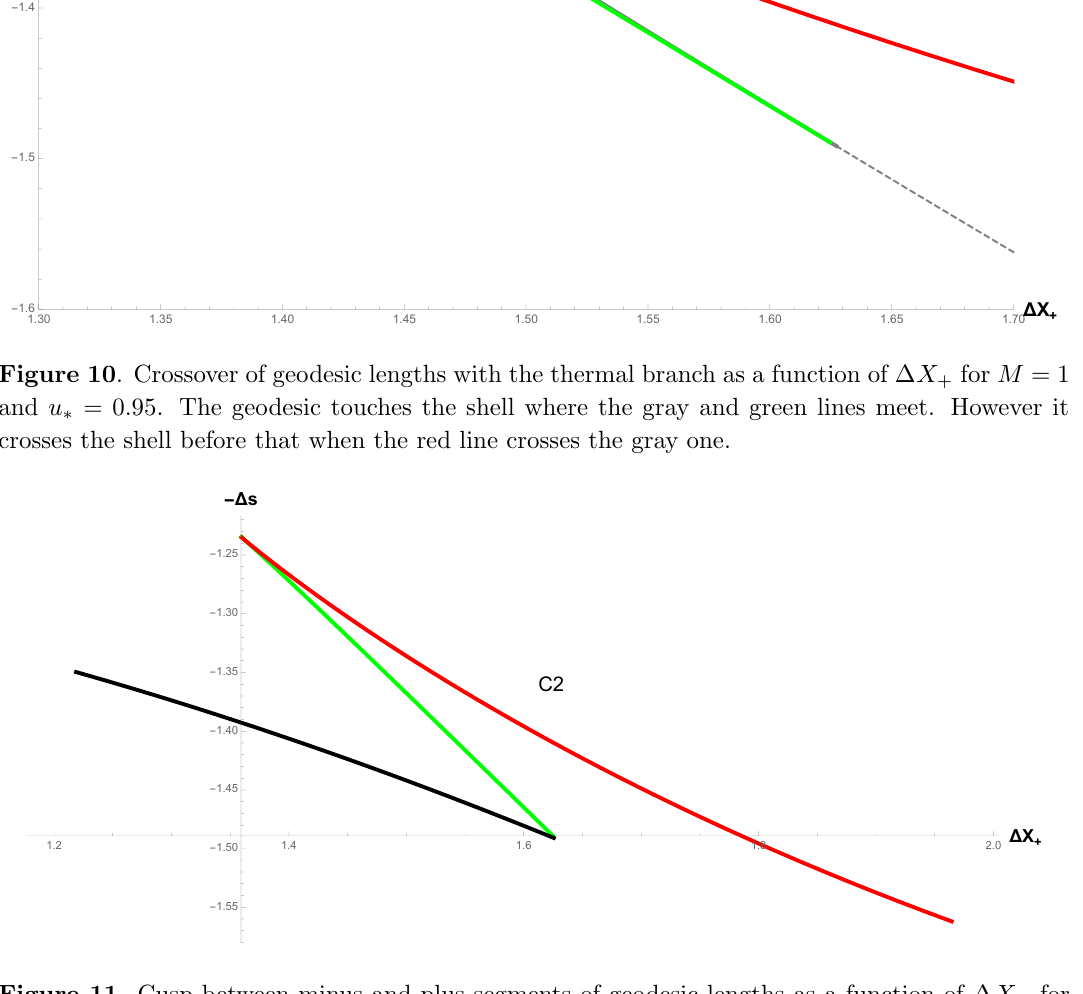
Figure 11 . Cusp between minus and plus segments of geodesic lengths as a function of (cid:1) X + for M = 1 and u (cid:3) = 0 :